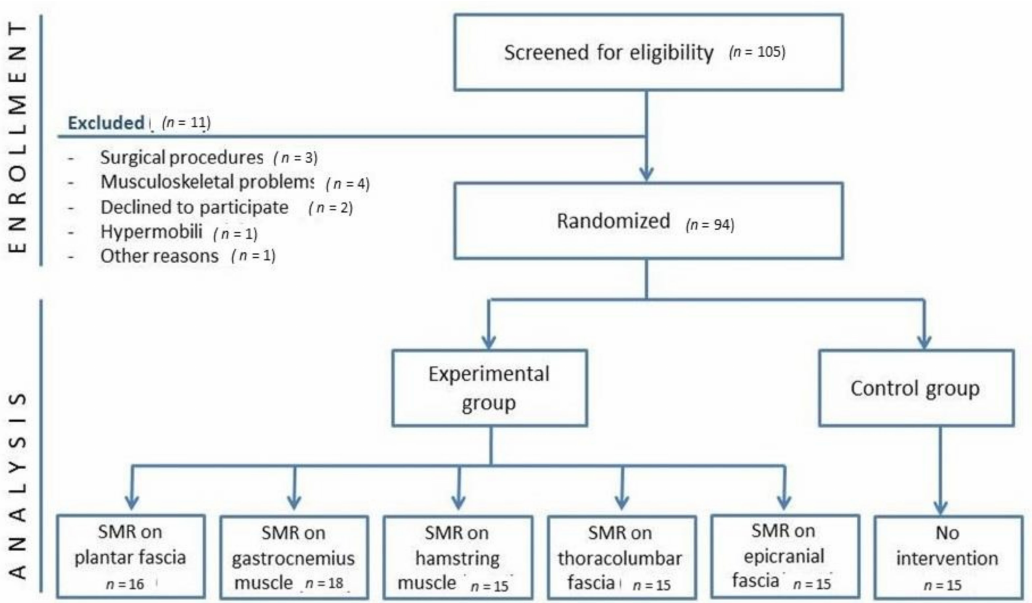
Figure 1. Flow chart of the